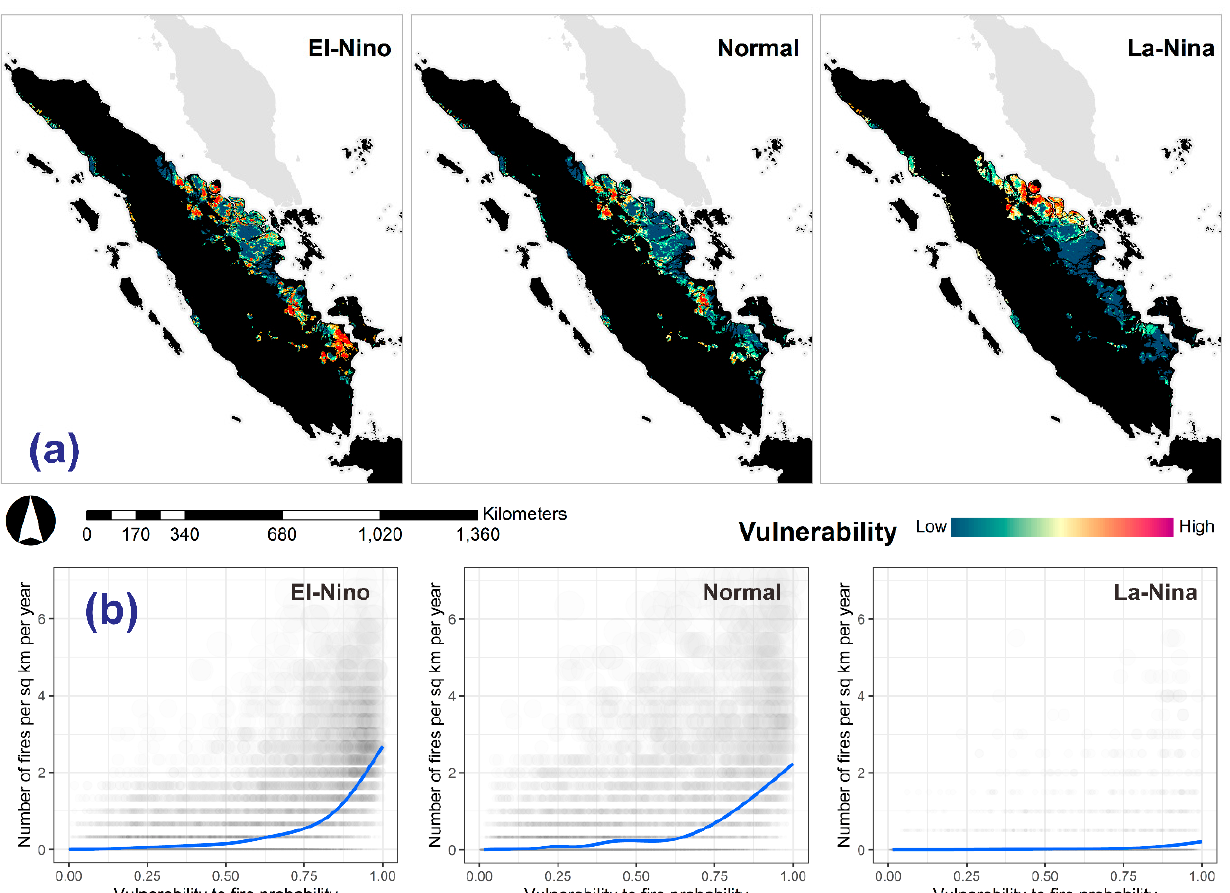
Figure 5. Spatial Sumatran peat vulnerability probability to fire based on the ensemble model ( a ) and relationships between number of fire density and vulnerability to fire probability ( b ) during various ENSO phases.